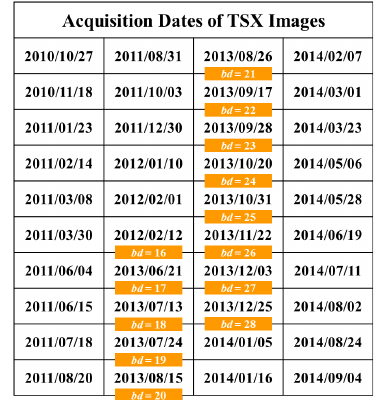
Figure 2. Flowchart of multi-break-date change detection.